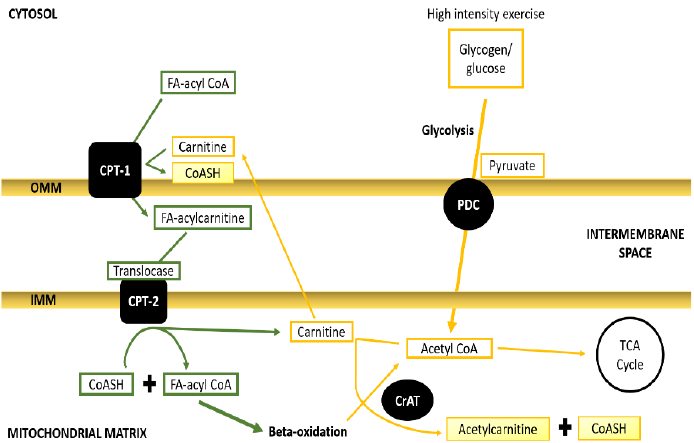
Figure 3. Fatty acid acyl-CoA–carnitine shuttle. Adapted from Jeppesen and Kiens [82]. Carnitine palmitoyl transferase (CPT)-1 mediates fatty acid (FA) acyl-CoA interconversion with free carnitine to FA-acylcarnitine, promoting transport into intermembrane space. The translocase enzyme facilitates FA-acylcarnitine entry into the mitochondrial matrix. CPT-2 regenerates free carnitine and FA acyl-CoA, which now can be oxidised. Carnitine acetyltransferase (CrAT) is a matrix enzyme with two polarities. The reverse reaction (presented above) breaks down acylcarnitine to feed acetyl-CoA into tricarboxylic acid (TCA)/Krebs cycle (particularly during metabolic inertia). When glycolytic flux through pyruvate dehydrogenase complex (PDC) is matched to a new steady state, CrAT favours the forward reaction consuming free carnitine for acylcarnitine regeneration to mop the excess acetyl lead to inhibition of FA-carnitine shuttle via CrAT forward